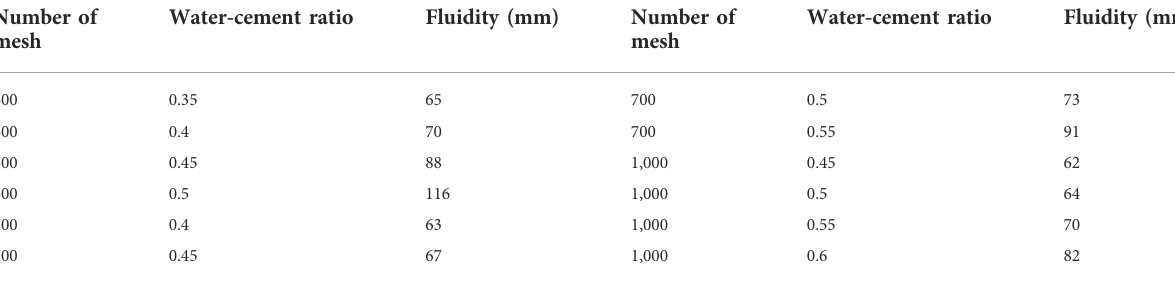
TABLE 4 Fluidity of super fi ne cement with different water cement ratio. Number of Water-cement mesh